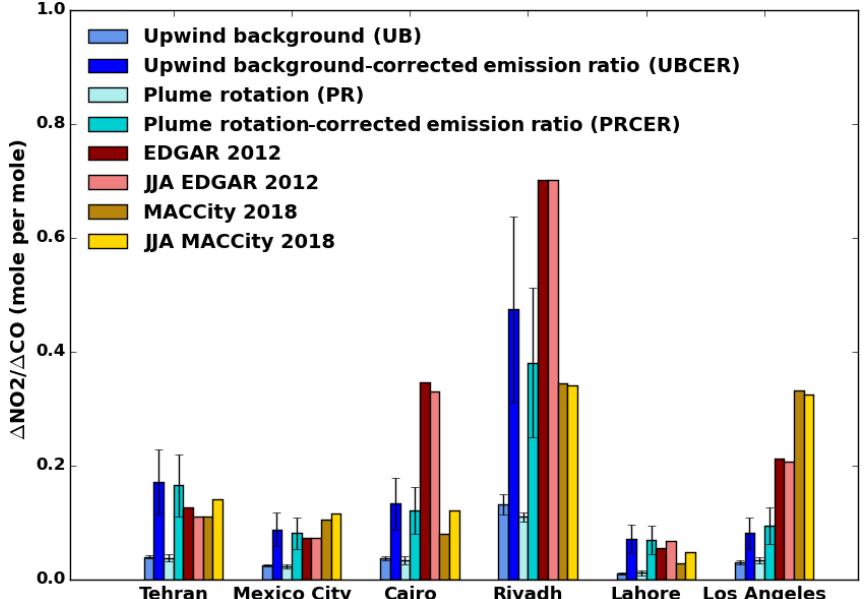
Figure 4. Comparison of TROPOMI-derived (cid:49) NO 2 /(cid:49) CO enhancement ratios, calculated using the different methods shown in shades of blue, with the corresponding emission ratios from the EDGAR (shown using shades of red) and MACCity (shown using shades yellow) emission inventories for six megacities. Dark solid shades for emission inventories represent the annual average inventory-derived ratio, whereas the lighter shades represent the June to August averaged inventory-derived ratios. The upwind background-corrected emission ratio (UBCER) and the plume rotation-corrected emission ratio (PRCER) account for the impact of photochemical NO 2 removal and the averaging kernel. Error bars for the TROPOMI-derived (cid:49) NO 2 /(cid:49) CO enhancement ratios represent 1 σ uncertainties calculated using bootstrapping (upwind background) and error propagation (plume rotation method). The error bars for UBCER and PRCER account for the uncertainty in the methodology and TROPOMI data (for details, see Table S3).